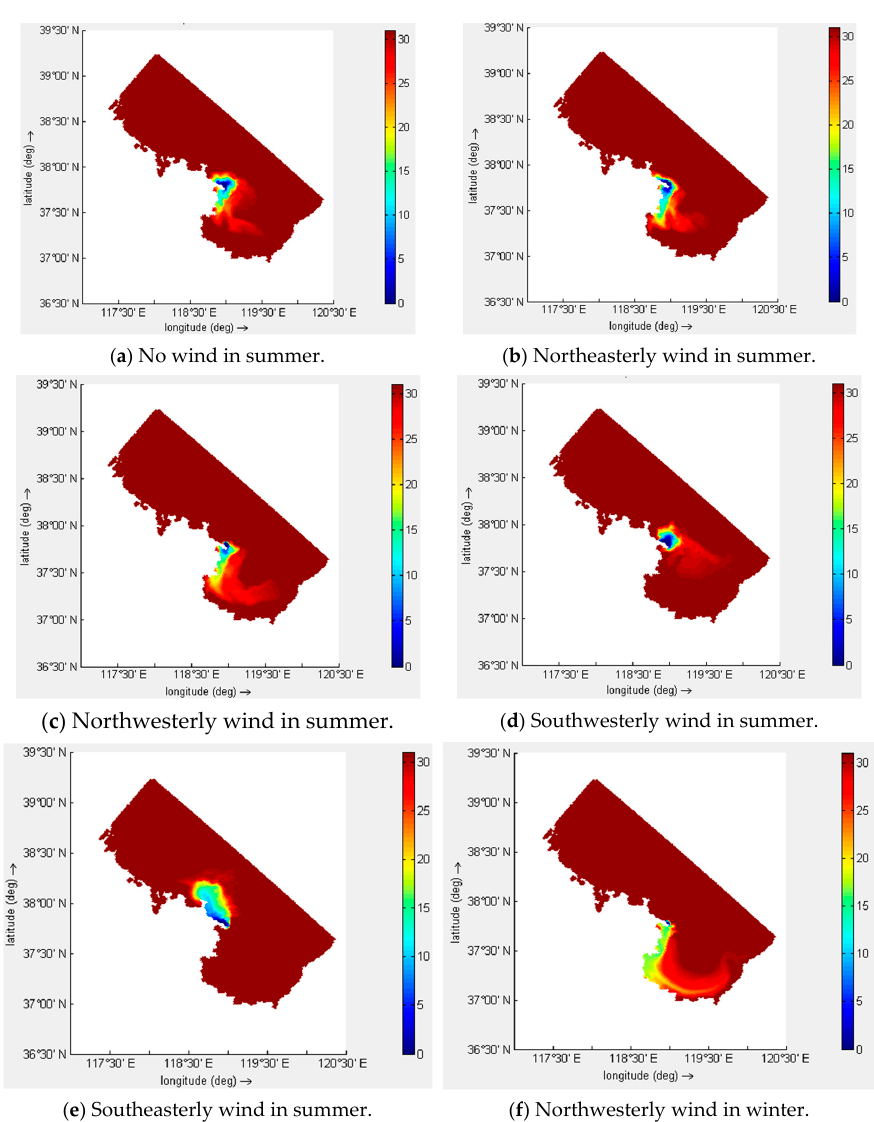
Figure 7. The diffusion of suspended sediment ( a – c ) and water ( b – f ) in the Yellow River delta dur- ing the summer flood periods in 2016 ( a , d ) and 2017 ( b , e ), and the winter flood period in 2017 ( c , f ).